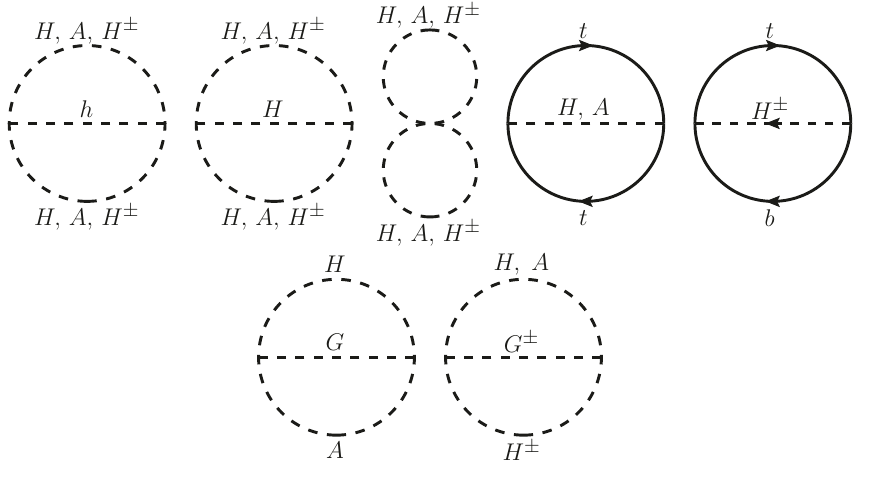
Figure 7 . New dominant two-loop BSM diagrams contributing to the effective potential of the CSI-2HDM — in addition to the leading SM diagrams of figure 1. The diagrams in the second line all vanish in the limit of degenerate BSM scalar